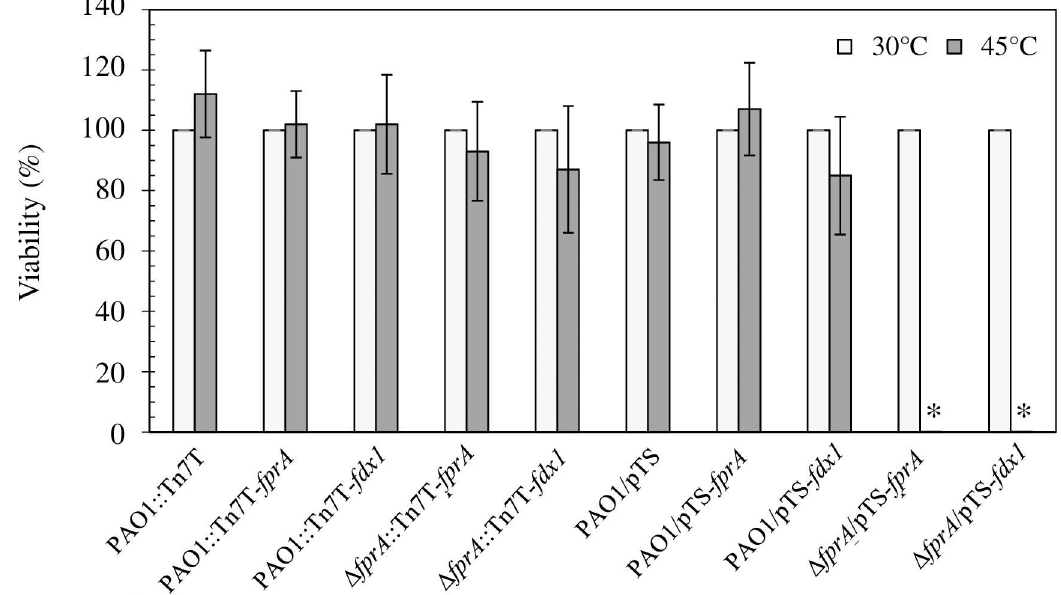
Fig 1. fprA is an essential gene in P . aeruginosa . The viabilityof exponential-phasecultures of P . aeruginosa PAO1 and Δ fprA mutant strains harboringan extra copy of fprA or fdx1 was determinedusing viable cell count on LB agar plates incubatedat either 30˚C or 45˚C. The viabilityis expressedas a percentage of the CFU of the tested strain over the CFU of the PAO1::Tn7T or PAO1/pTS control.